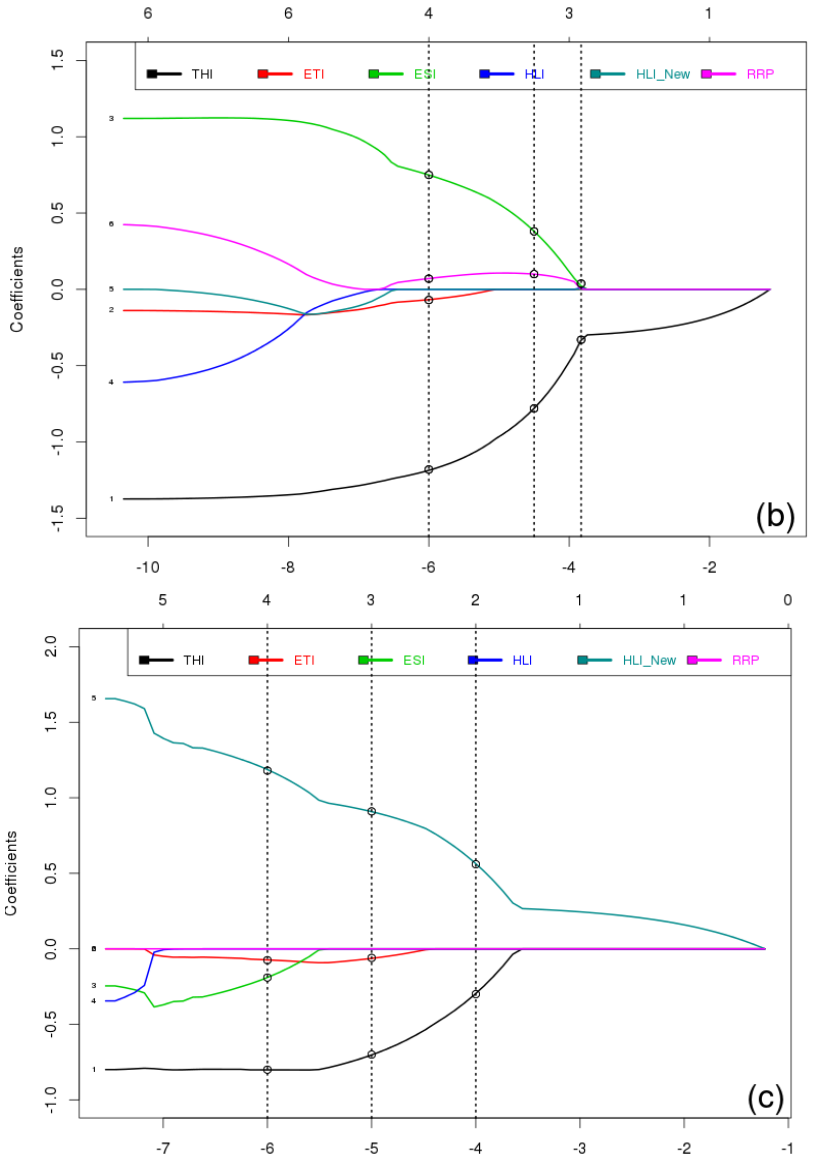
Figure 4. Least Absolute Shrinkage and Selection Operator (LASSO) analysis to find the best multiple linear regression model between climate indices and milk yield ( a ), fat ( b ), and protein ( c ), from 2002 to 2010 in spring. On the bottom X axis, the shrinkage regularization factor is given in logarithmic units (log λ). The number on top of the figure indicates the number of Lasso selected predictors at the log λ value.